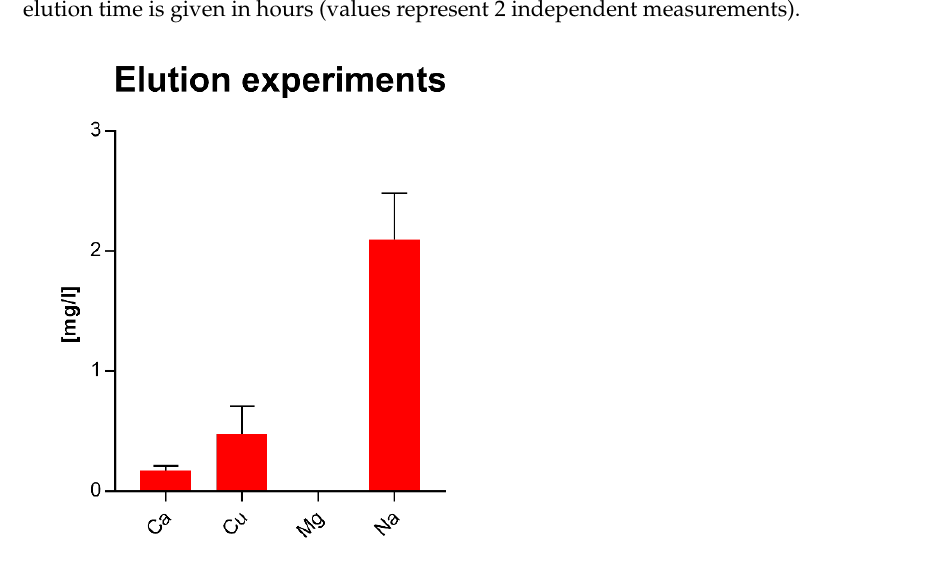
Figure 5. Long-term behavior of Cu release in leaching experiment. The different sol–gel components were after the maximum leaching period of 163 h again exposed to an additional period of 19 h in the same setup. Values for Cu release were low with values between 0.25 and 0.6 mg/L.